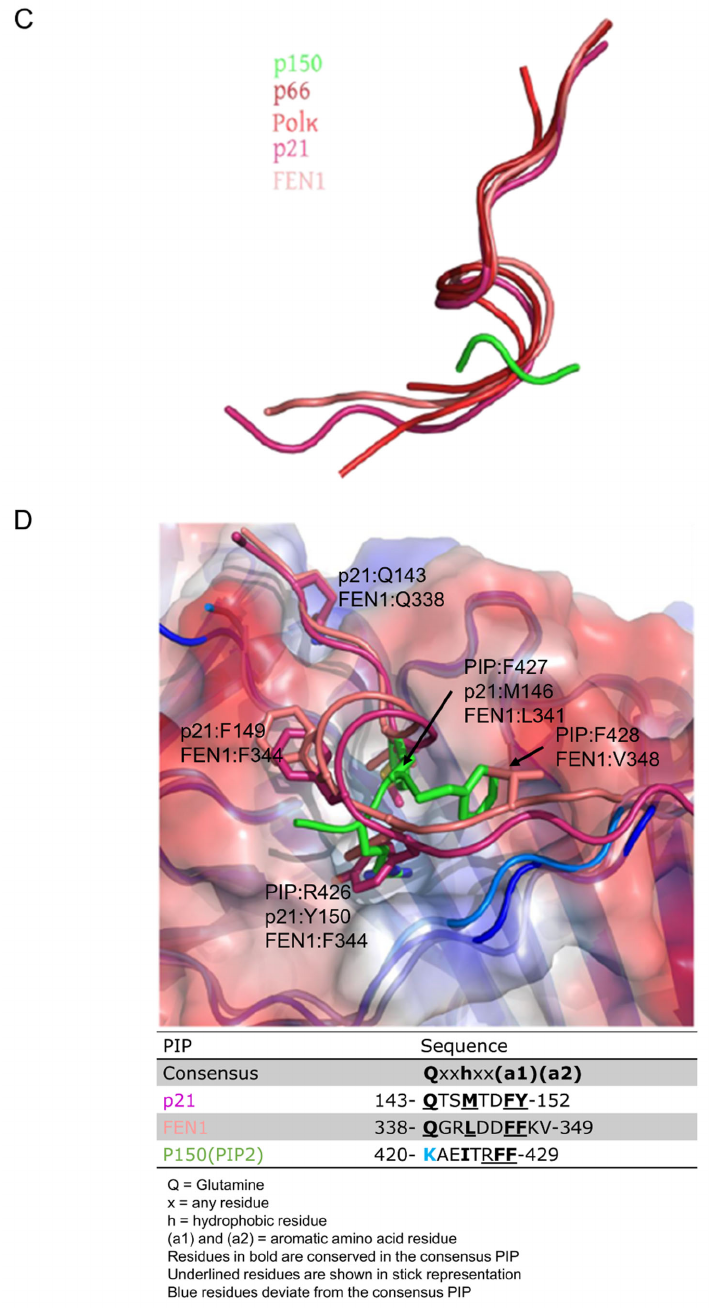
Figure 3. Cation- π interaction and orientation of PIP binding with respect to PCNA. ( A ) CAF-1 p150 Figure 3. Cation ‐π interaction and orientation of PIP binding with respect to PCNA. ( A ) CAF ‐ 1 p150 PIP Arg 426 forms a cation ‐π interaction with Tyr 250 of PCNA. The side chain of PCNA Pro 234, PIP Arg 426 forms a cation- π interaction with Tyr 250 of PCNA. The side chain of PCNA Pro 234, Tyr 250, Ala 252, Met 40, Leu 126, Pro 129, and Leu 47 are shown in stick representation (light blue). Side chains of p150 PIP are shown in stick representation (green). Arg 426 of PIP extends into the hydrophobic pocket on the surface of PCNA and forms a cation- π interaction with Tyr 250. Bond length is measured between the terminal nitrogen of R426 and the center of the aromatic ring of Tyr 250. ( B ) Hydrophobic interaction between PCNA and p150 PIP. The side chains of the PCNA residues listed in ( A ) are shown in stick representation (light blue). The p150 PIP side chains are shown in stick representation (green). Phe 427 of the p150 PIP nestles into a hydrophobic surface of PCNA composed of Pro 129, Tyr 250, Leu 47, and Met 40 residues. Phe 428 of the p150 PIP is less deeply buried in the hydrophobic surface of PCNA. ( C ) Paths of polypeptide chains when the PIPs of different proteins are bound to PCNA. The drawing is derived from the co-crystal structures of